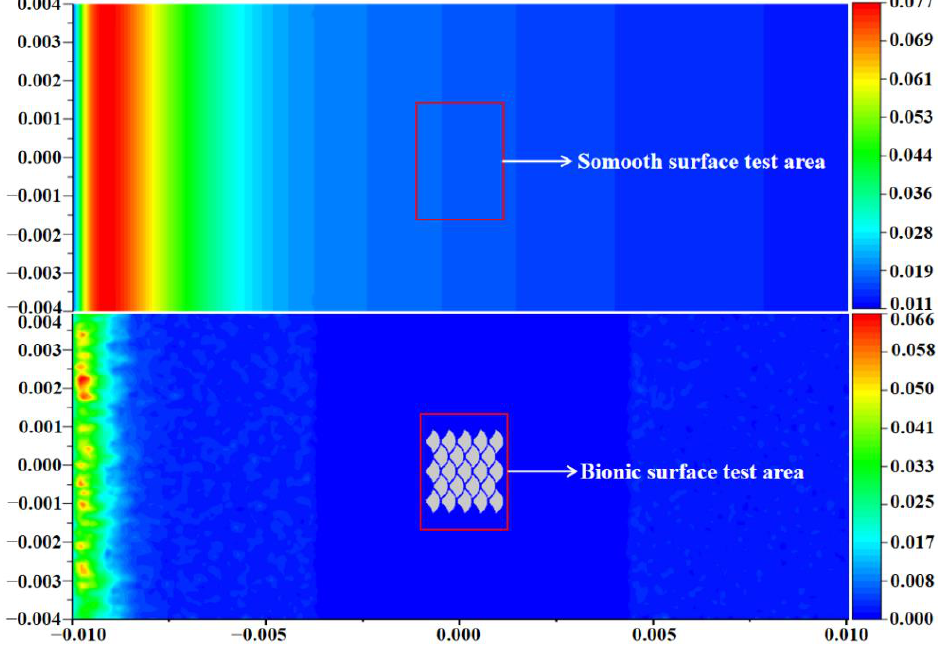
Figure 18. Turbulent energy cloud diagram on the upper and lower surfaces.